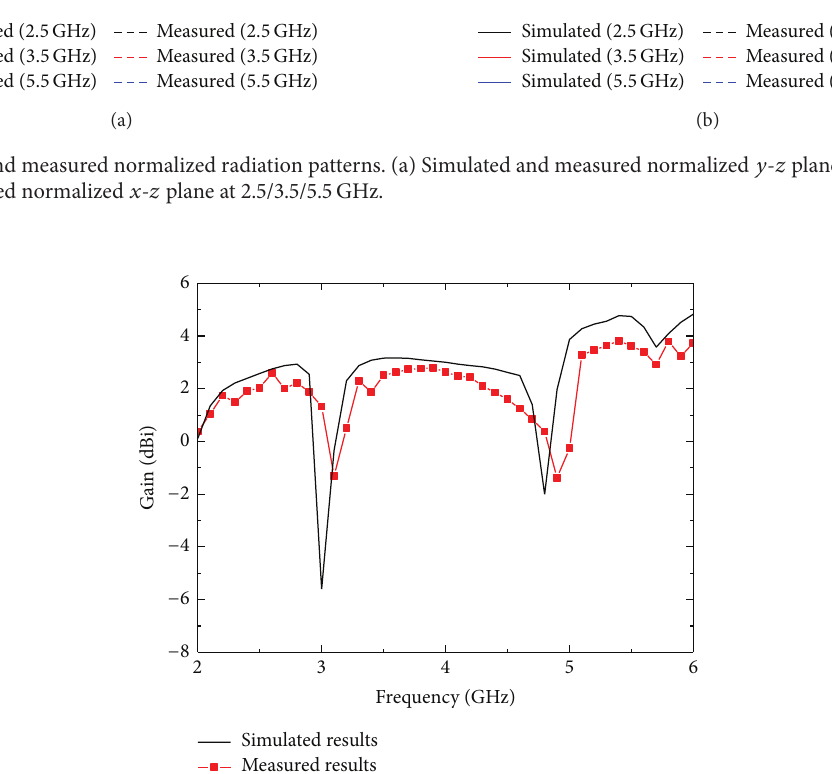
frequency for the second stop-band varies from 4.72 GHz to 4.92 GHz when the first stop-band keeps nearly stable, which is plotted in Figure